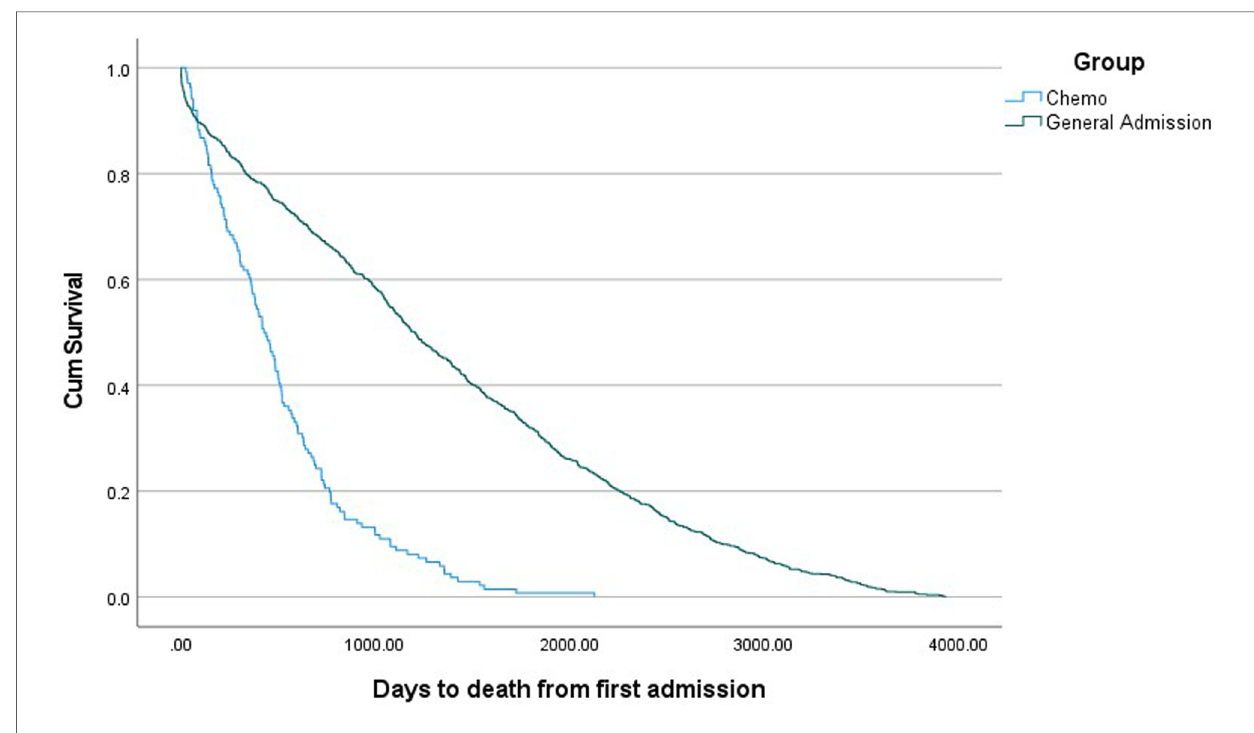
FIGURE 2 Cumulative survival according to patient